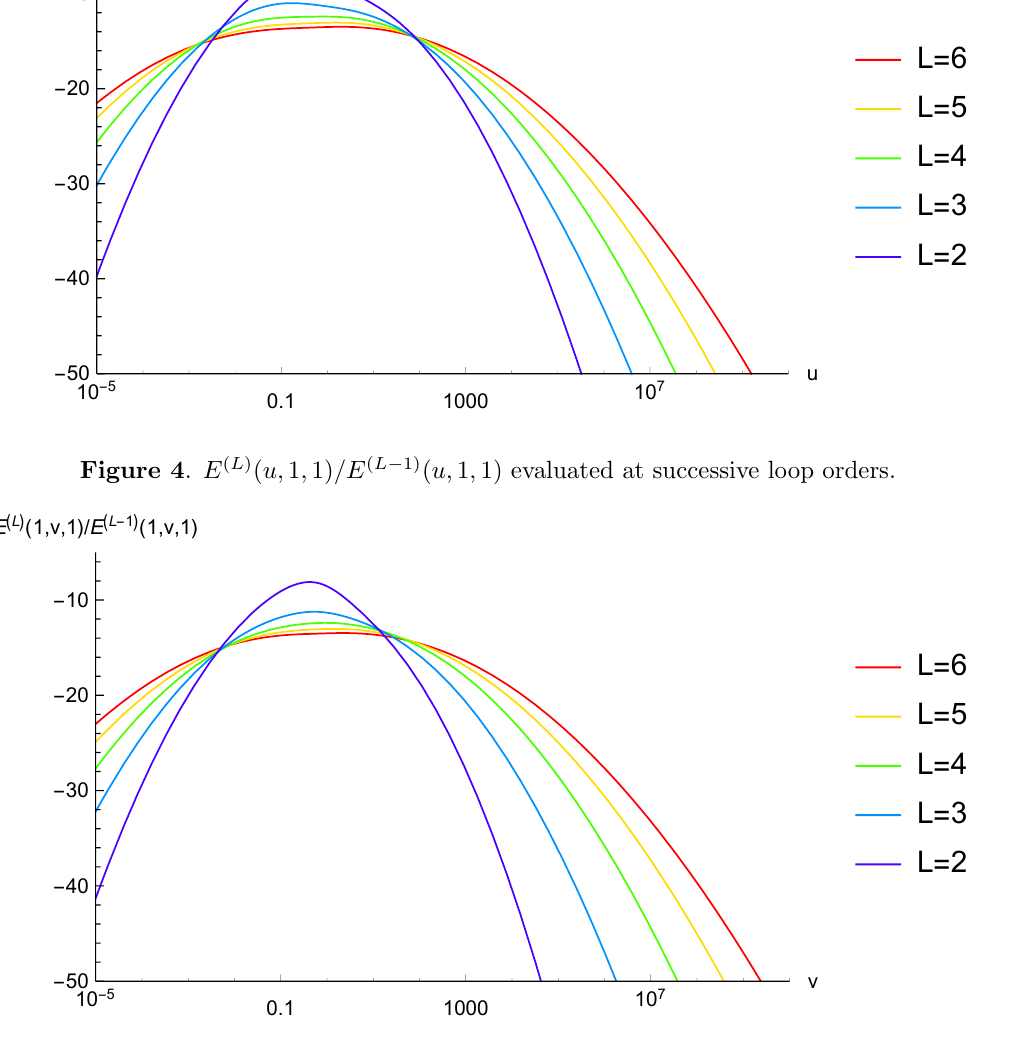
Figure 5 . E ( L ) (1 ; v; 1) =E ( L (cid:0) 1) (1 ; v; 1), evaluated at successive loop